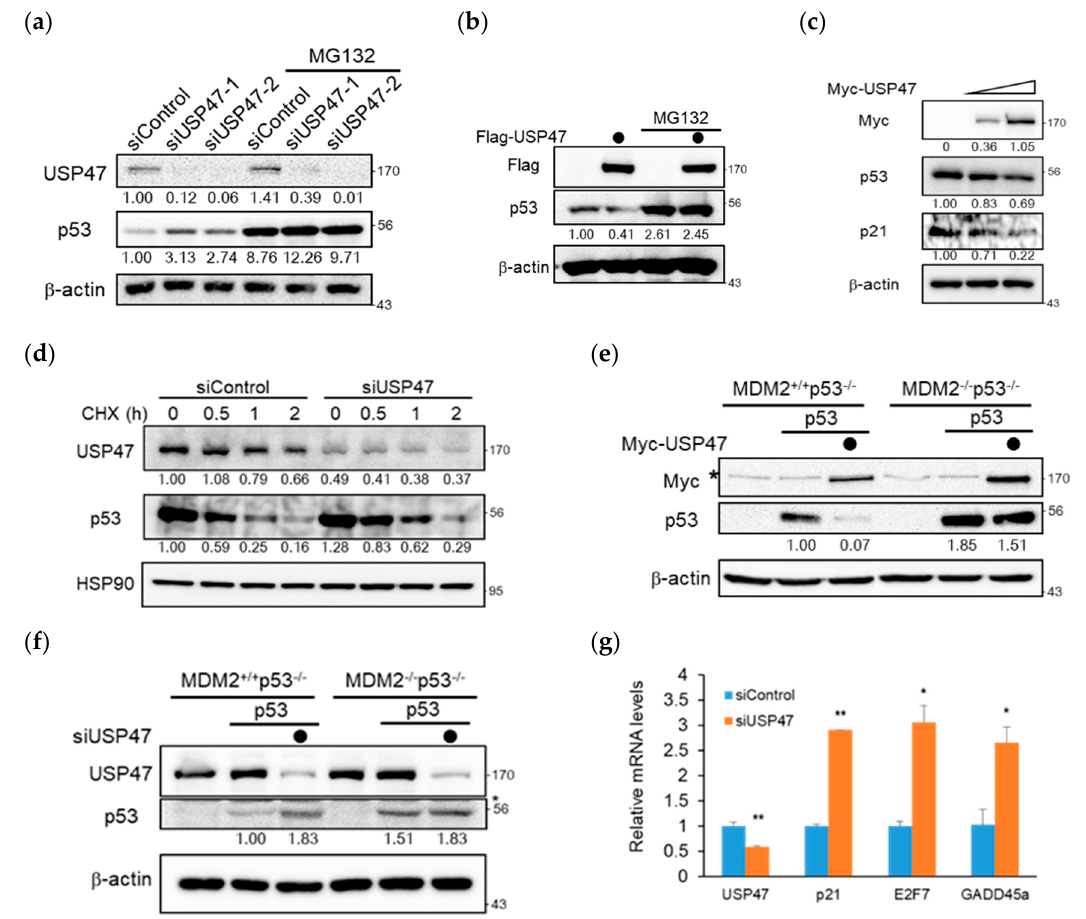
Figure 2. USP47 regulates p53 in an MDM2-dependent manner. ( a ) HeLa cells transfected with siRNA against control or USP47 were treated with either DMSO (control) or MG132 (10 μ M) for 4 h. Cell lysates were immunoblotted with the indicated antibodies. β -actin was used as a loading control. The band intensity was measured by Image J and then normalized by β -actin. ( b ) U2OS cells overexpressed with Flag vector or Flag-USP47 were treated with either DMSO (control) or MG132 (10 μ M) for 4 h. Cell lysates were immunoblotted with the indicated antibodies. ( c ) U2OS cells were overexpressed with increasing amounts of Myc-USP47 (0, 1, and 2 μ g). After 24 h, cell lysates were immunoblotted with the indicated antibodies. ( d ) U2OS cells transfected with siRNA against control or USP47 were treated with 100 μ g/mL cycloheximide and harvested at the indicated times. Cell lysates were immunoblotted with the indicated antibodies. HSP90 was used as a loading control. The band intensity was normalized by HSP90. ( e ) MDM2 +/+ p53 − / − and MDM2 − / − p53 − / − Mouse Embryonic Fibroblast (MEF) cell lines were co-overexpressed with p53, Myc-USP47, and then cell lysates were immunoblotted with the indicated antibodies. The non-specific band is denoted by an asterisk. ( f ) MDM2 +/+ p53 − / − and MDM2 − / − p53 − / − Mouse Embryonic Fibroblast (MEF) cell lines were overexpressed with p53 for 24 h and then transfected with siRNA against control or USP47 for 48 h. Cell lysates were immunoblotted with the indicated antibodies. The non-specific band is denoted by an asterisk. ( g ) The real-time PCR analysis of p53 downstream genes in A549 cells transfected with siRNA against control or USP47 for 48 h. Relative expression values are normalized against β -actin RNA levels, and graphs are shown as fold induction over control siRNA transfected cells. Data from three independent experiments represented by mean ± SD (* p < 0.05, ** p < 0.01, t -test). The uncropped blots and molecular weight markers are shown in Figure S7.